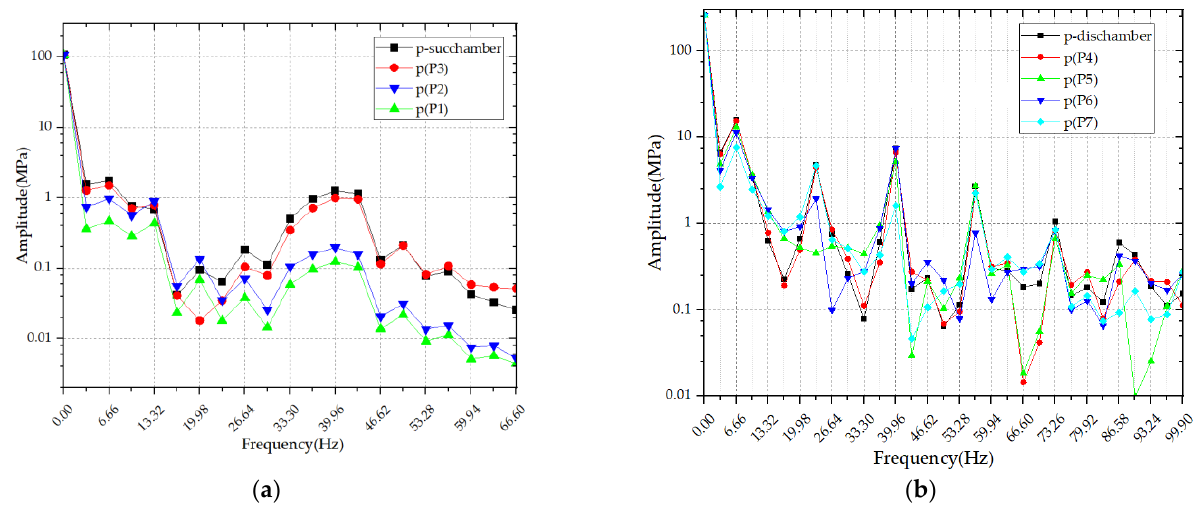
Figure 11. Amplitude – frequency curves of the pressure. ( a ) Amplitude – frequency curves in the inlet pipeline; ( b ) Amplitude – frequency curves in the outlet pipeline.